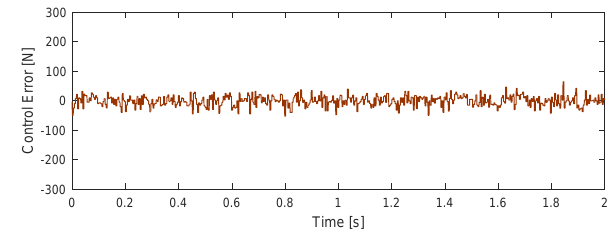
Figure 17: Elimination of limit cycle oscillations, steady-state.